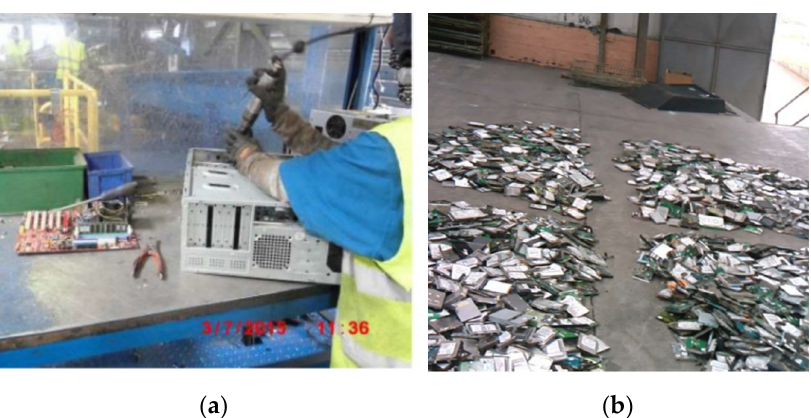
Figure 2. ( a ) Manual disassembly of the personal desk computers. ( b ) HDDs sorted for sampling